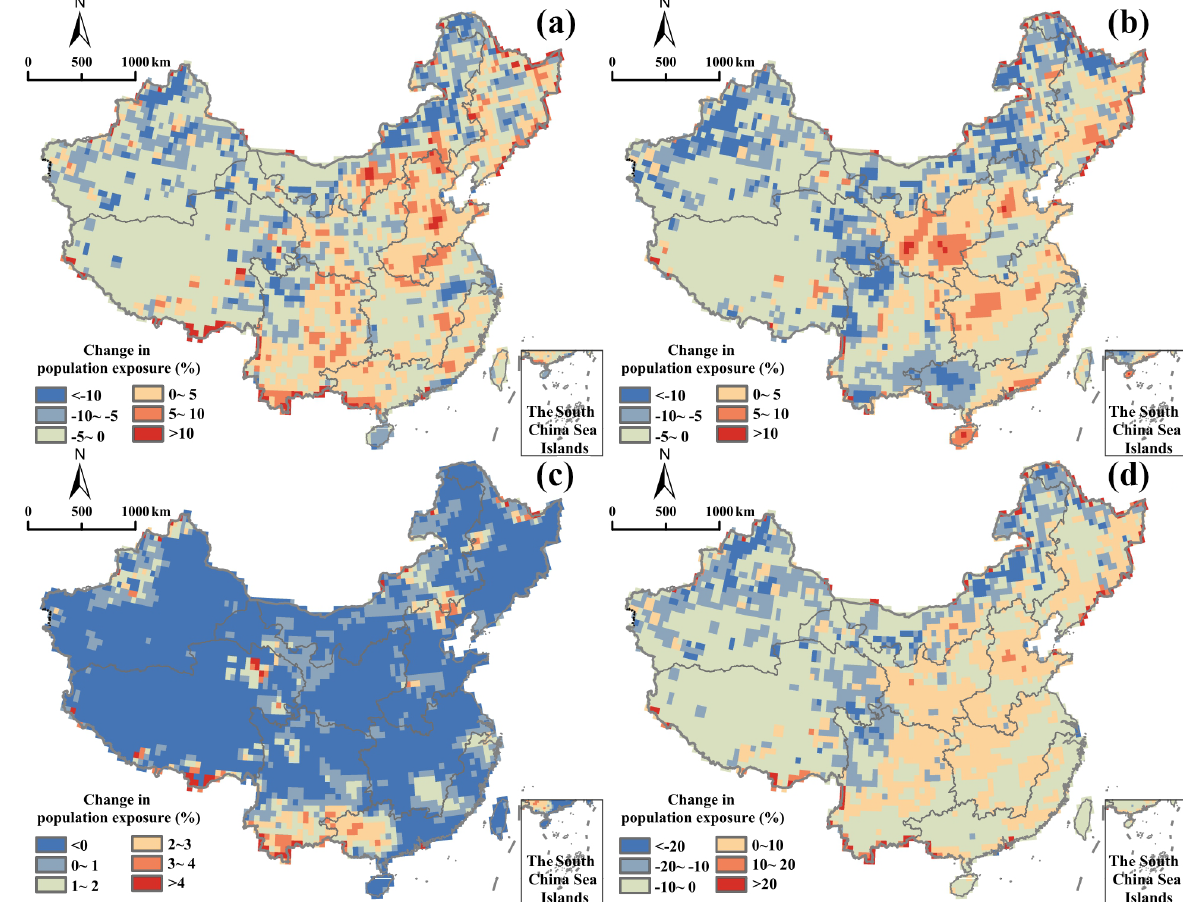
Figure 3. Change in population exposure to droughts between the reference period (1986–2005) and the 1.5 ◦ C global warming scenario (2020–2039 in RCP2.6), (a) change in exposure to mild droughts, (b) change in exposure to moderate droughts, (c) change in exposure to extreme droughts, and (d) change in exposure to all droughts. Please note that the above figure contains disputed territories.